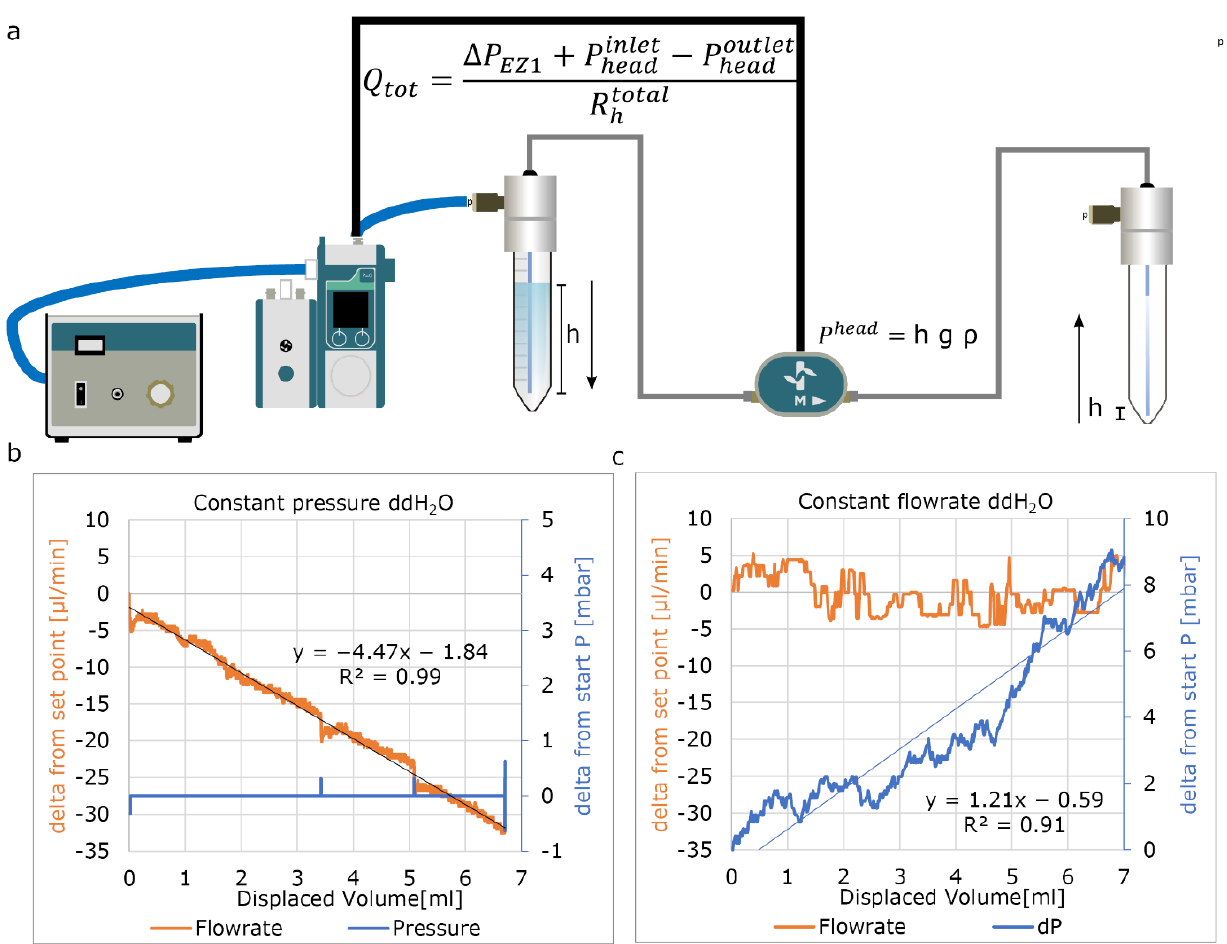
Figure 5. Controlling flow rate with fixed parameters. ( a ) Used fluidic circuit. ( b ) Applying a fixed pressure difference results in a constant decrease of the flow rate per displaced volume due to effect of P head . ( c ) Fixed flow rate shows a steady increase in applied pressure due to the changing P head using fixed flow rate.